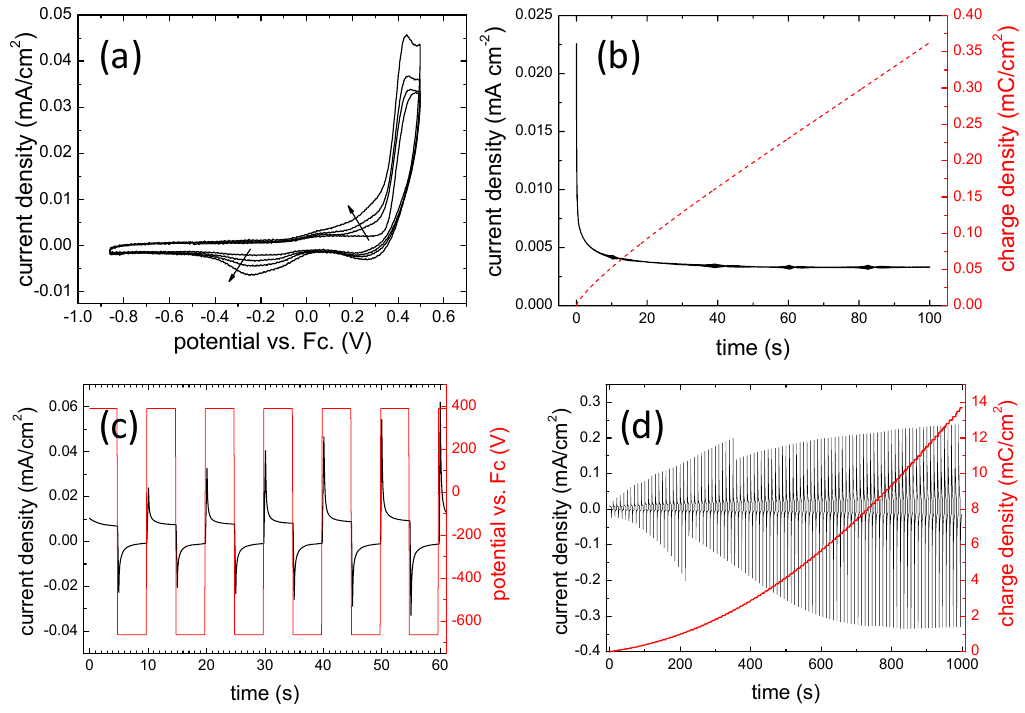
Figure 4. Polymerization of DEHT-V-BTD by different electrochemical techniques: ( a ) three cyclic voltammetry (CV) cycles; ( b ) potentiostatic (PS) at 0.39 V for 100 s: current/time (black) and charge/time (red) profiles; ( c ) first six steps of the pulsed-potentiostatic (PPS): current/time (black) and potential/time (red) profiles; and ( d ) PPS: current/time (black) and charge/time (red) profiles.